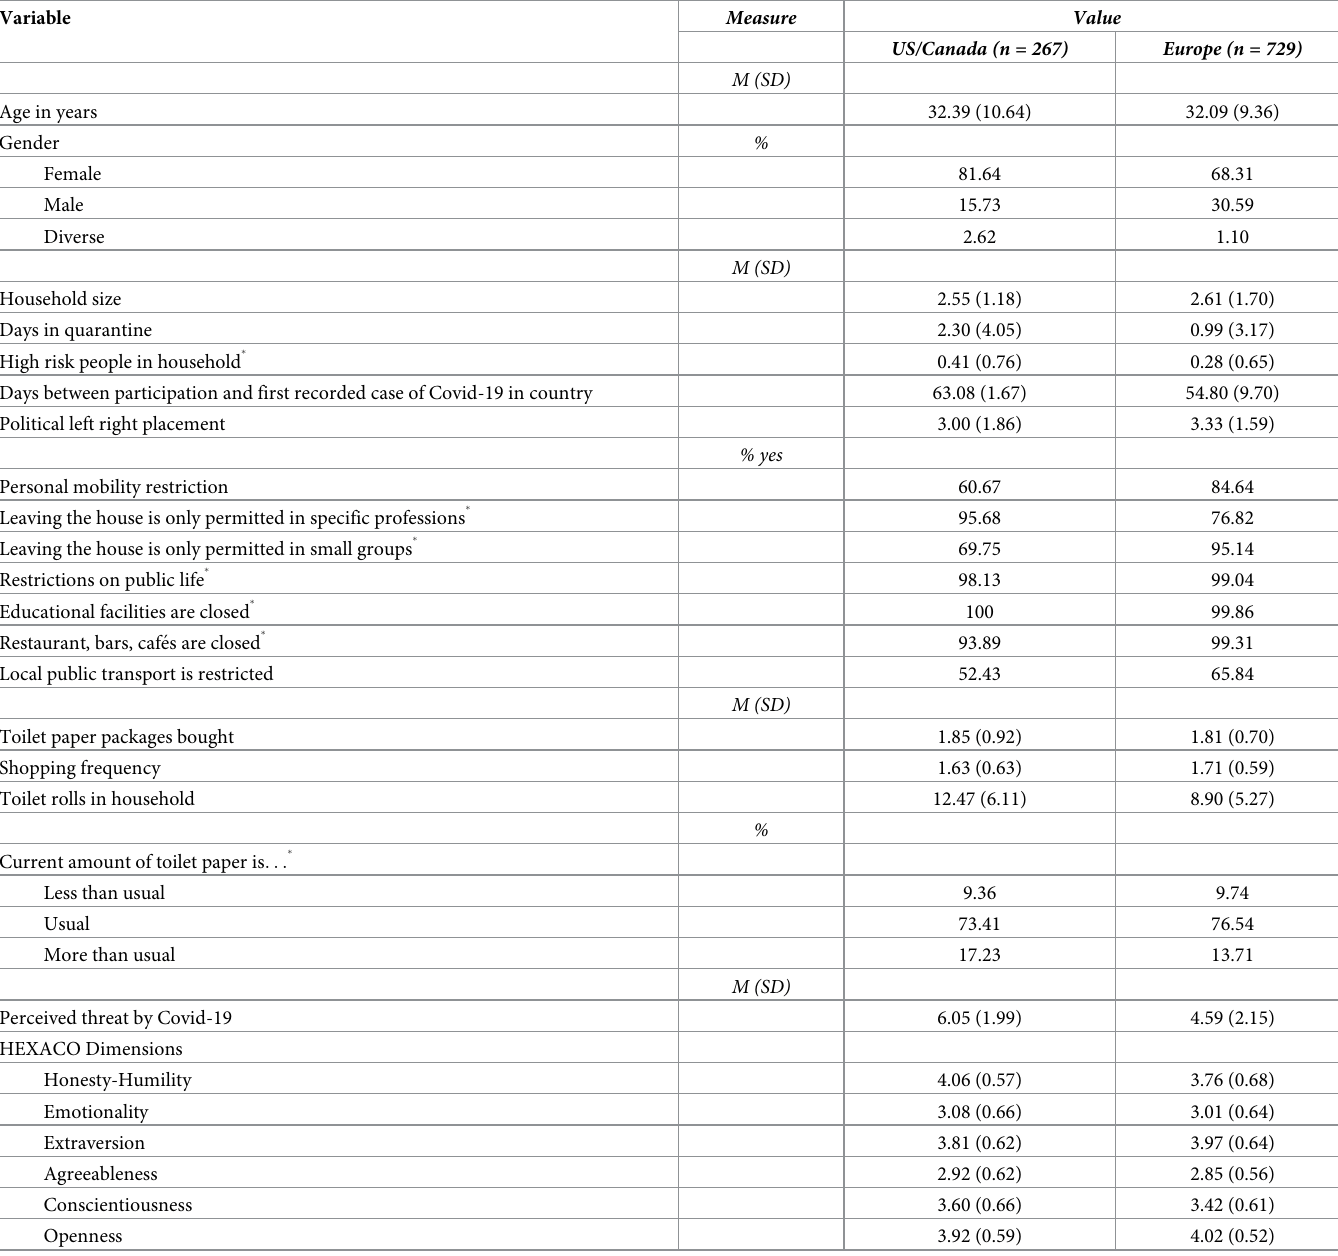
Table 1. Descriptive statistics by place of